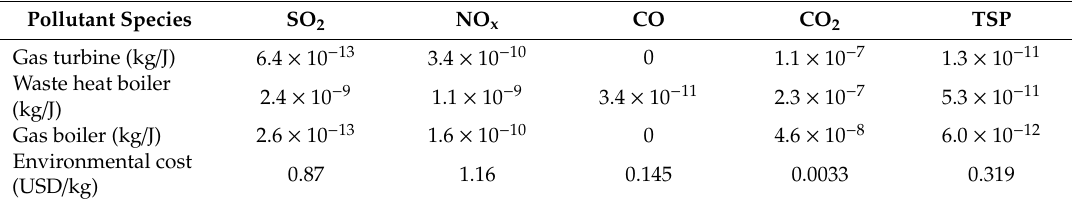
Table 2. Pollutant emission intensity and environmental cost of pollutants in the